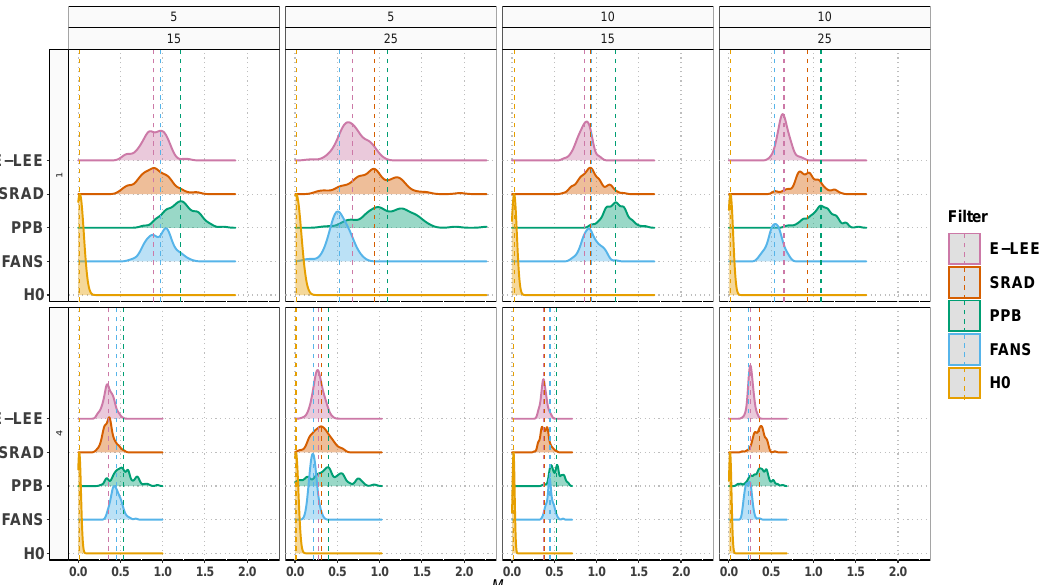
Figure 8. Kernel density estimates of the statistic The vertical dashed lines are the mean values. H0 is